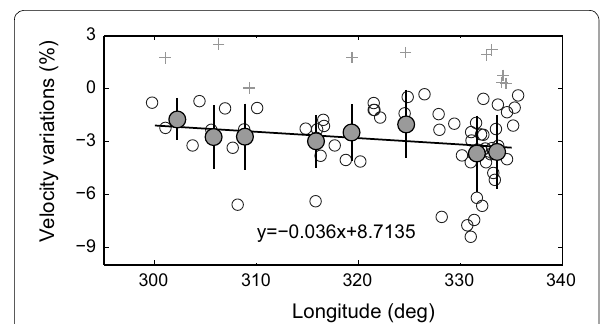
Fig. 8 P-wave velocity anomalies at the CMB near African Anomaly plotted as a function of sampling longitude. Slow and fast anomalies are shown in gray crosses and black circles , respectively. The binned data ( gray solid circles with one standard deviation) are calculated with a 10-degree moving window and a 5-degree overlap. Although there are several fast anomalies, the slow anomalies show a trend that the values decrease gradually with the increase of longitude, mean- ing the closer they are to the African Anomaly, the larger P-wave velocity reductions they